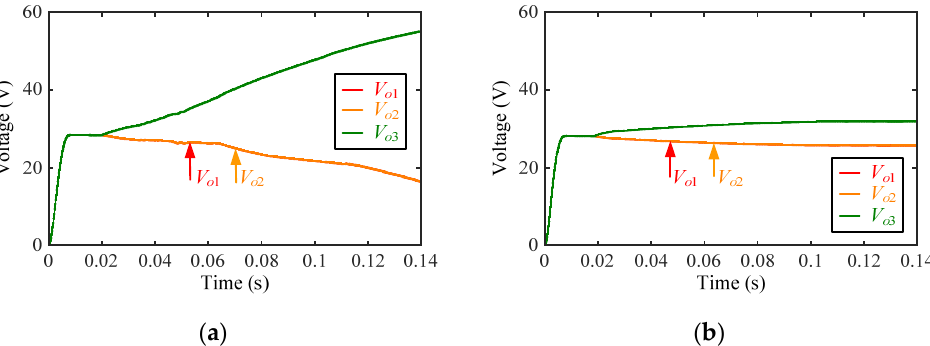
Figure 7. Output voltage waveforms under open-circuit conditions. ( a ) Without parameter optimization. ( b ) With parameter optimization.